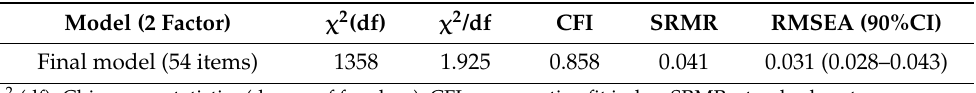
Table 5. Goodness of fit indices for the two factor